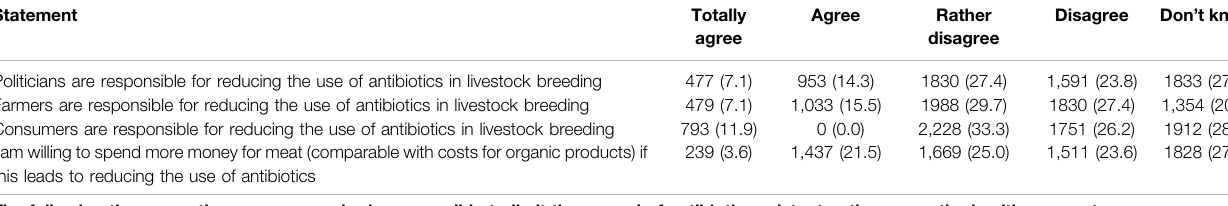
TABLE 3 | Different stakeholders ’ role to control the antibiotic resistance. Statement Totally